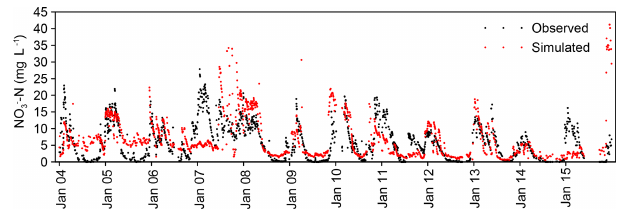
Figure 5. Observed and simulated NO − time scale for the entire study period.